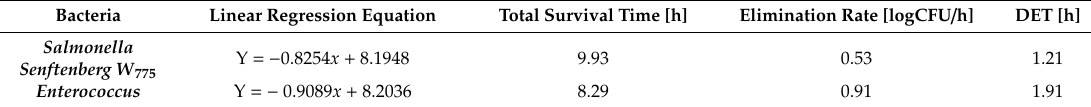
Figure 1. The regression line for change of kinetics of Salmonella population in laboratory scale. Table 2. Statistical parameters of inactivation of bacterial kinetics in laboratory